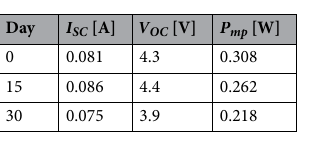
Table 5. Evolution of the characteristic values: Painted Aluminium (Plate